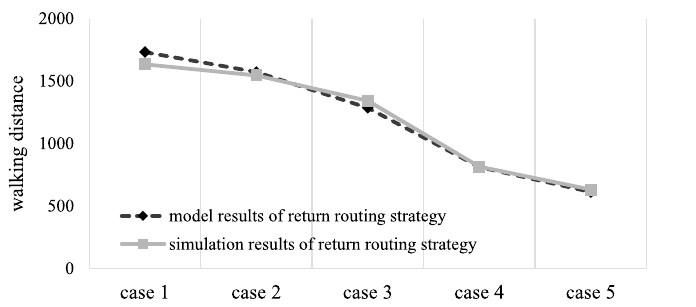
Figure 5. Comparison of the stochastic model results and simulation results for the return routing strategy.